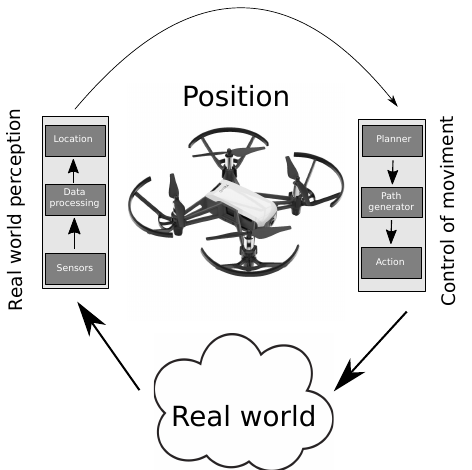
Figure 1. Conventional architecture for a path-planning